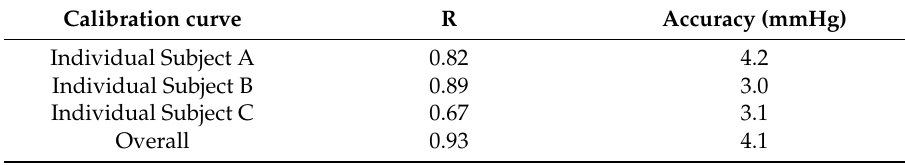
Table 1. Calibration data set of each subject.